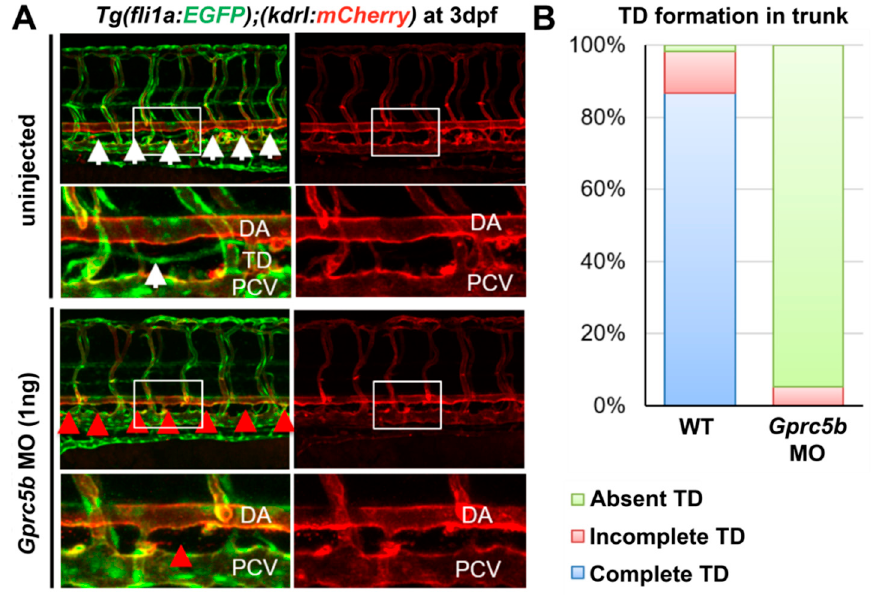
Figure 2. Zebrafish gprc5b morphant embryos exhibit decreased lymphatic vessel formation. ( A ) Confocal images of Tg(fli1a: EGFP); Tg(kdrl: Hsa.HRASmCherry) control (uninjected) and 1 ng of gprc5ba morpholino-injected larvae at 72 h post-fertilization (hpf). The boxes in the above panels are enlarged in the bottom panels, respectively. White arrows point to EGFP-positive TD in the trunk region. Red arrows point to defects in TD formation in the trunk region. Anterior to the left, dorsal to the top. DA, dorsal aorta; PCV, posterior cardinal vein; TD, thoracic duct. ( B ) Quantification of EGFP-positive/kdrl-negative thoracic duct in the trunk (six somites). Uninjected embryos ( N = 10) and gprc5ba MO-injected larvae ( N = 13), from three independent clutches.